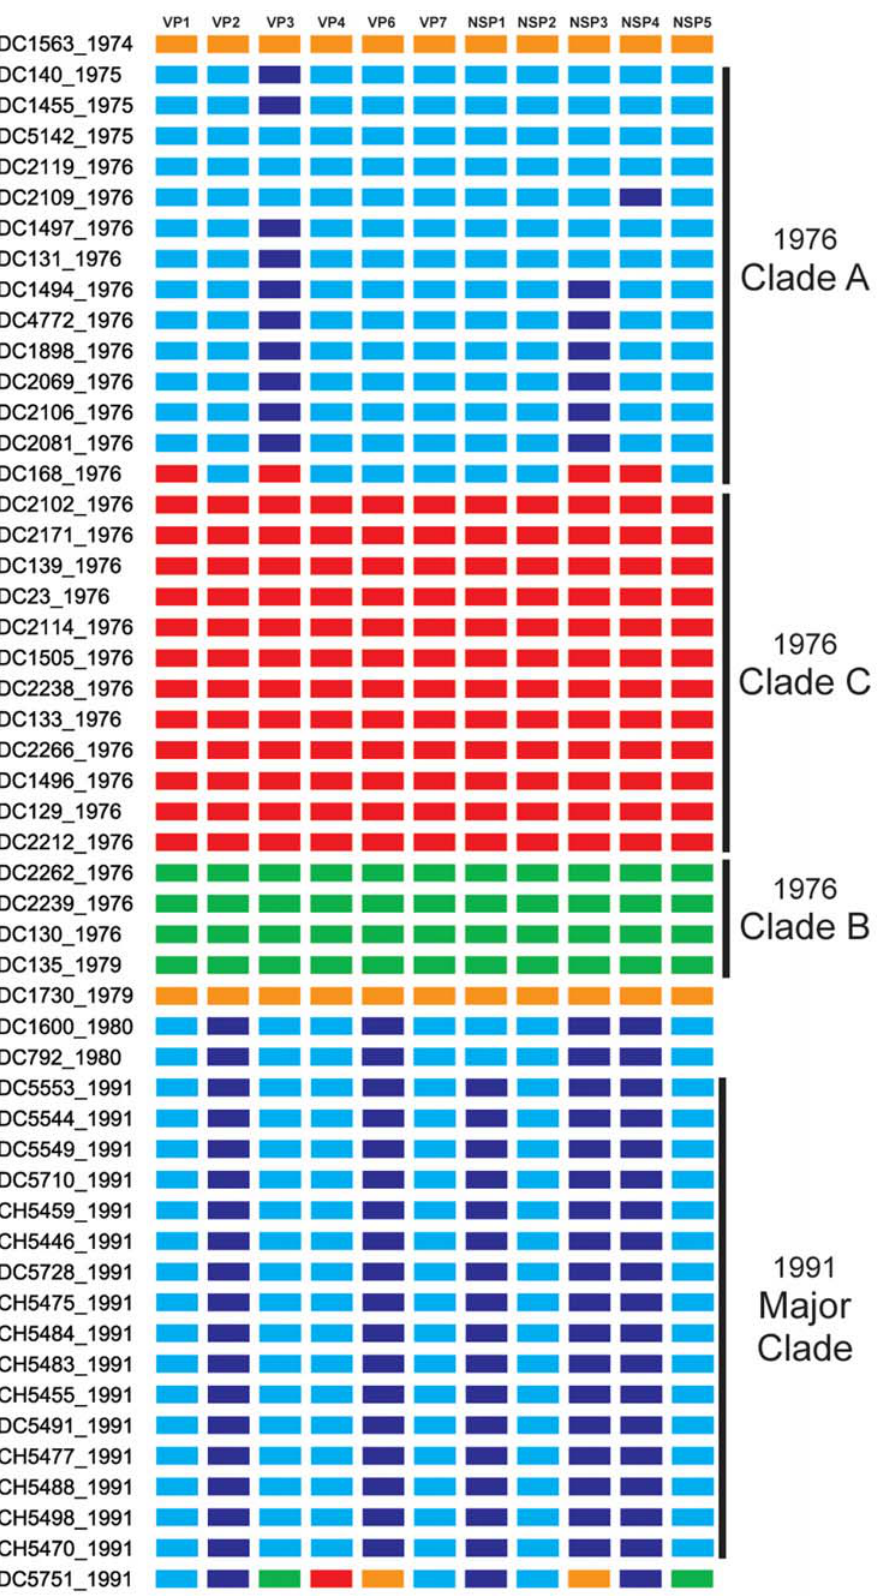
Figure 5. Allele-based Genome Constellations of the G3P[8] RVs. The schematic illustrates the color-coding of each gene allele for the G3P[8] isolates based on the phylogenies shown in Figures 2–4. The sample name and year of isolation is listed to the left of the corresponding genome constellation. The protein encoded by each gene is listed at the top. Isolates assigned into clades (1976 clades A, B, and C; 1991 major clade) are indicated.